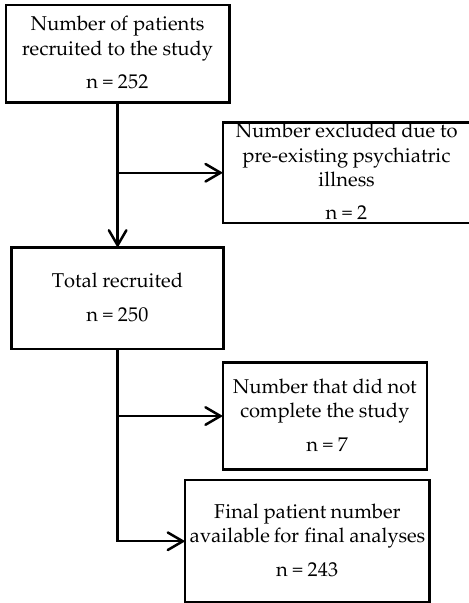
Figure 1 . Flow diagram detailing the selection of patient participants . Figure 1. Flow diagram detailing the selection of patient